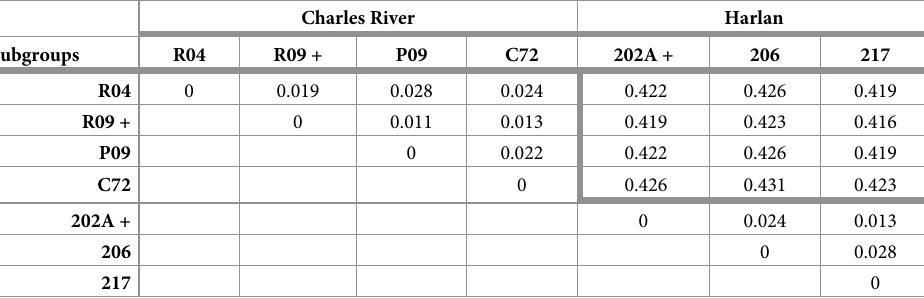
Table 1. Pairwise F ST statistics for Harlan and Charles River breeding